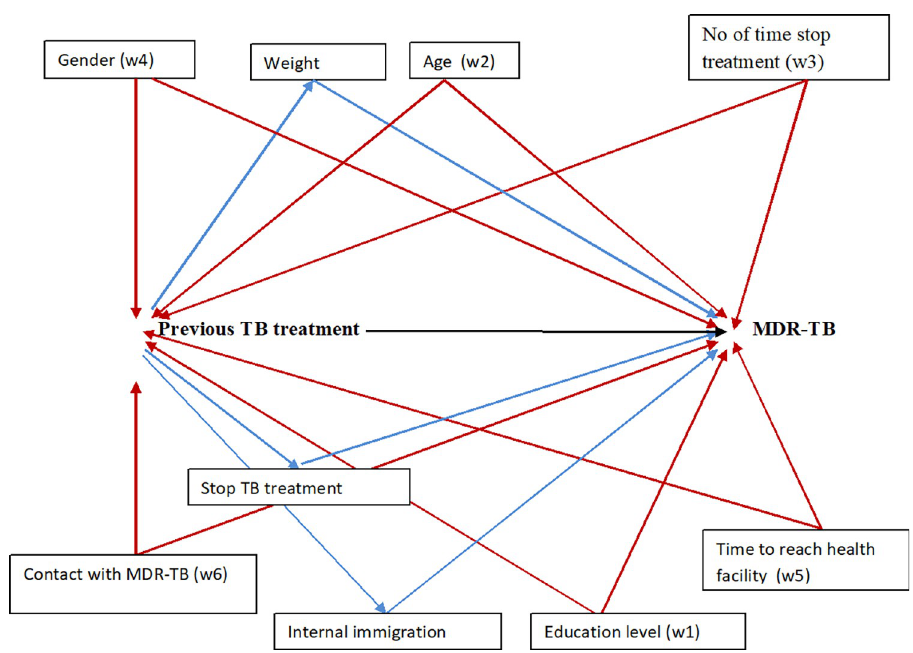
Fig 1. Direct acyclic graph (DAG) showing possible confounders in the association between previous tuberculosis treatment and Multidrug-resistant tuberculosis.